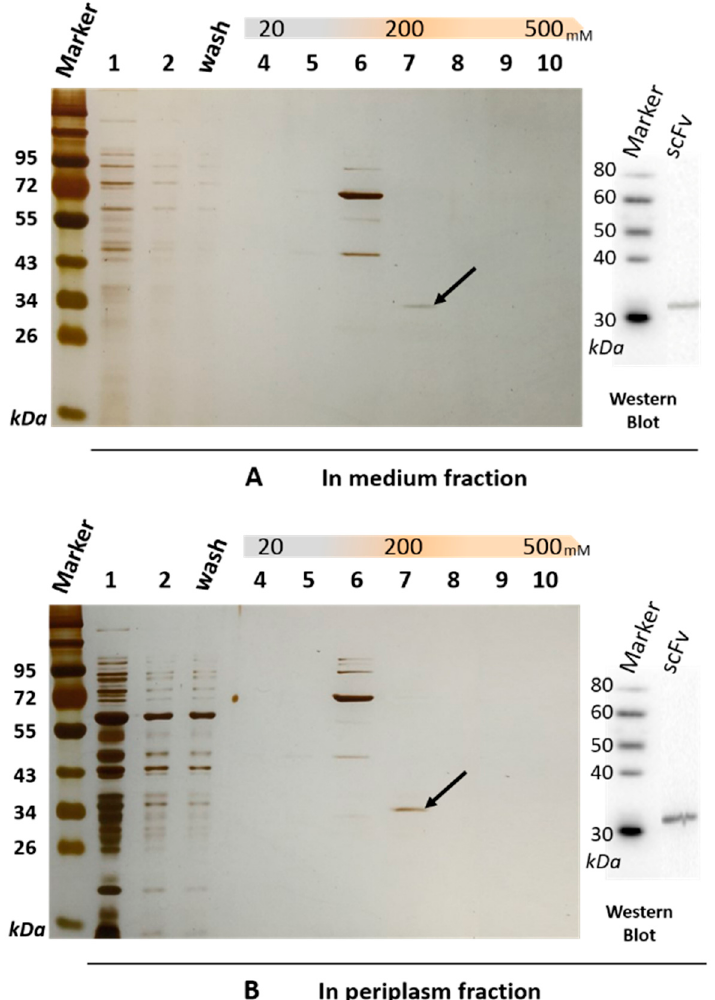
Figure 2. SDS-PAGE and immunoblotting analysis of the soluble anti-triazophos scFv-8C10 antibody purified from the medium fraction ( A ) and the periplasm fraction ( B ) via IMAC (immobilized metal ion affinity chromatography). Lane 1 , crude protein extract; Lane 2 , uncombined protein; Lane 3 , protein washed with binding buffer; Lanes 4 – 10 , protein eluted with 20, 50, 100, 200, 300, 400, and 500 mM imidazole in a buffer of 20 mM Tris–HCl, pH 7.4, 500 mM NaCl. The scFv-8C10 antibody with a size of 31 kD is pointed out by a black arrow and probed by anti-His-tag antibody on PVDF (polyvinylidene difluoride) membrane.